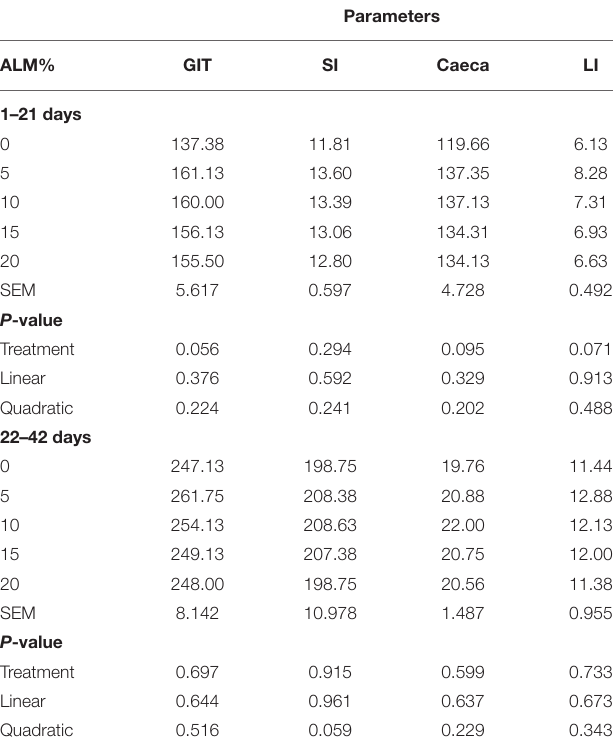
TABLE 11 | Effect of amaranth leaf meal inclusion on gut organ digesta pH of Ross 308 broiler Parameters